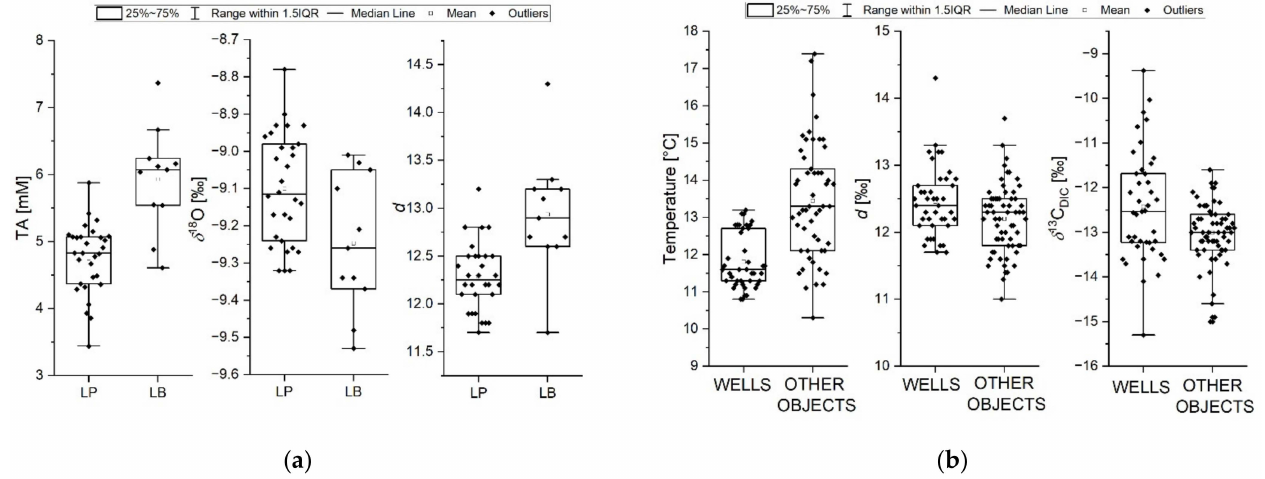
Figure 8. ( a ) Observed statistically significant differences for TA, δ 18 O, and d-excess between wells presented at Ljubljansko polje (LP; N = 30) and Ljubljansko barje (LB; N = 11). ( b ) Observed statistically significant differences in T, d-excess, and δ 13 C DIC between wells (N = 41) and other components in the WSS (N =